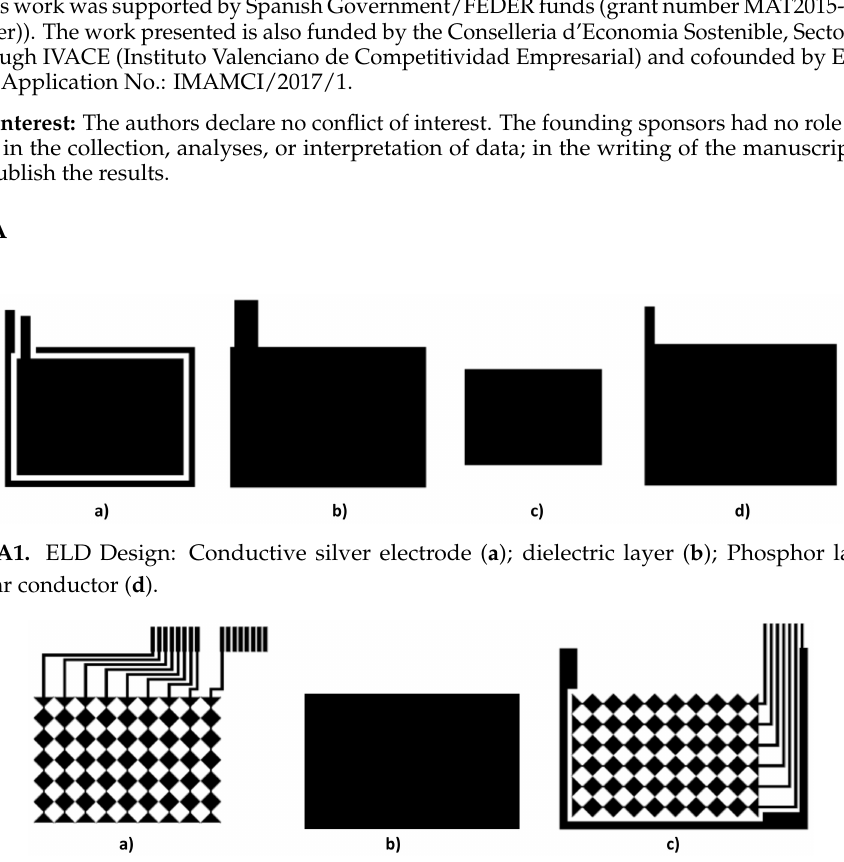
Figure A2. 2D Touchpad Design: Vertical or X layer ( a ); dielectric layer ( b ); and Horizontal or Y layer ( c